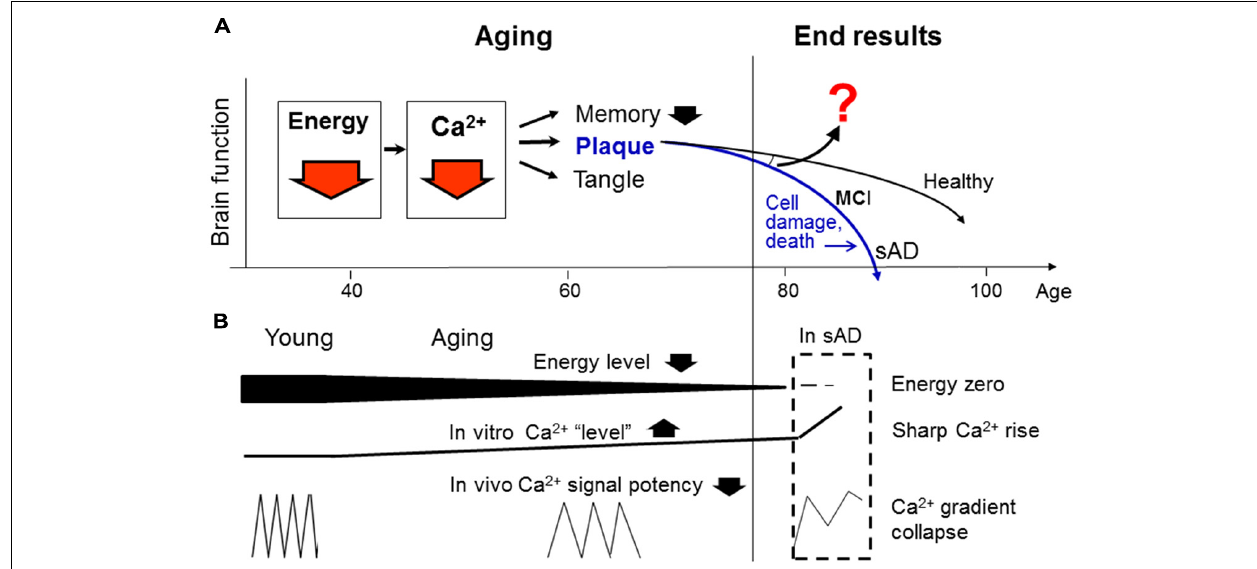
FIGURE 1 |An integrative model for the “natural history” of sporadic Alzheimer’s disease (sAD). (A) Proposes that energy deficiency is the earliest modifiable defect in brain aging, which causes, among other things, a Ca 2 + signaling deficit underlying inefficient memory and the formation of plaques and tangles (by means of inactivating Ca 2 + -dependent proteases and phosphatases; not shown, see text below). (B) Explains why energy deficit decreases Ca 2 + signal potency (by reducing Ca 2 + wave frequency), and why this change can manifest as slow rising Ca 2 + “levels” during aging and sharp Ca 2 + rises in cell death. As the aging process continues